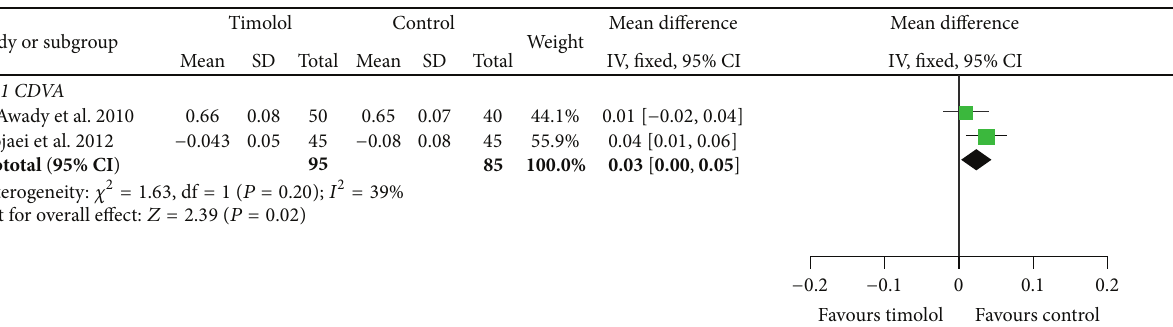
Figure 7: Comparison of logMAR CDVA between the two groups in two